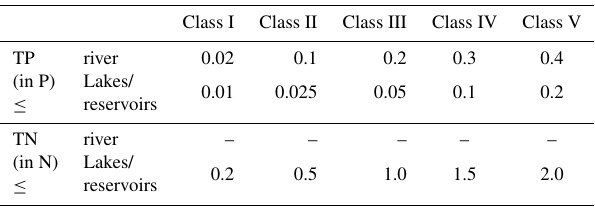
Table 1. Part water quality standard limit of environmental quality standards for surface water (unit: mgL − 1